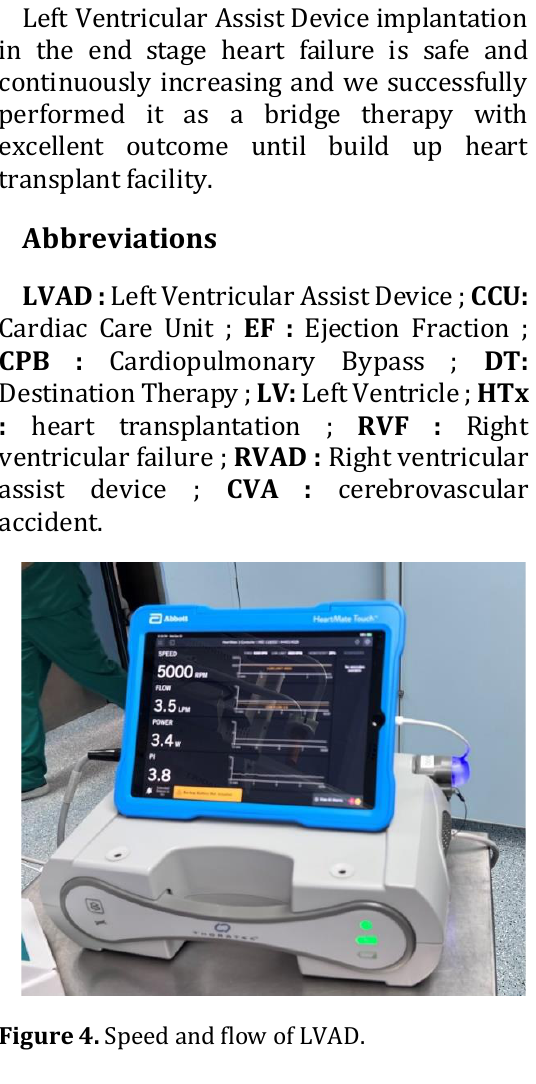
Figure 3. Driveline before subcutaneous insertion.